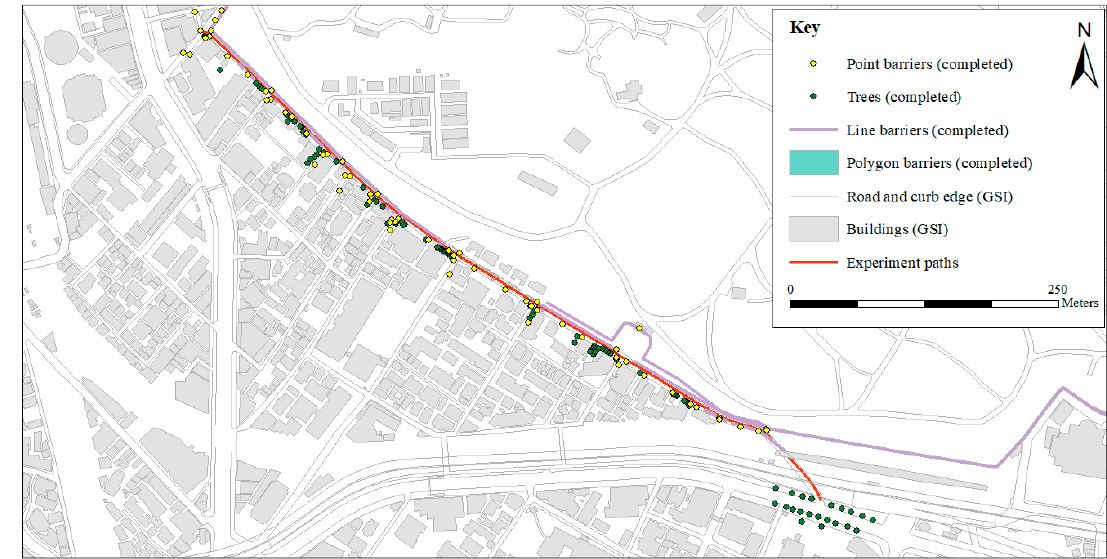
Figure 7. Map showing the completed barriers (point/line/polygon) layer, completed trees layer, GSI building footprints, GSI road and curb edge, and experiment paths I, III, IV, and V.